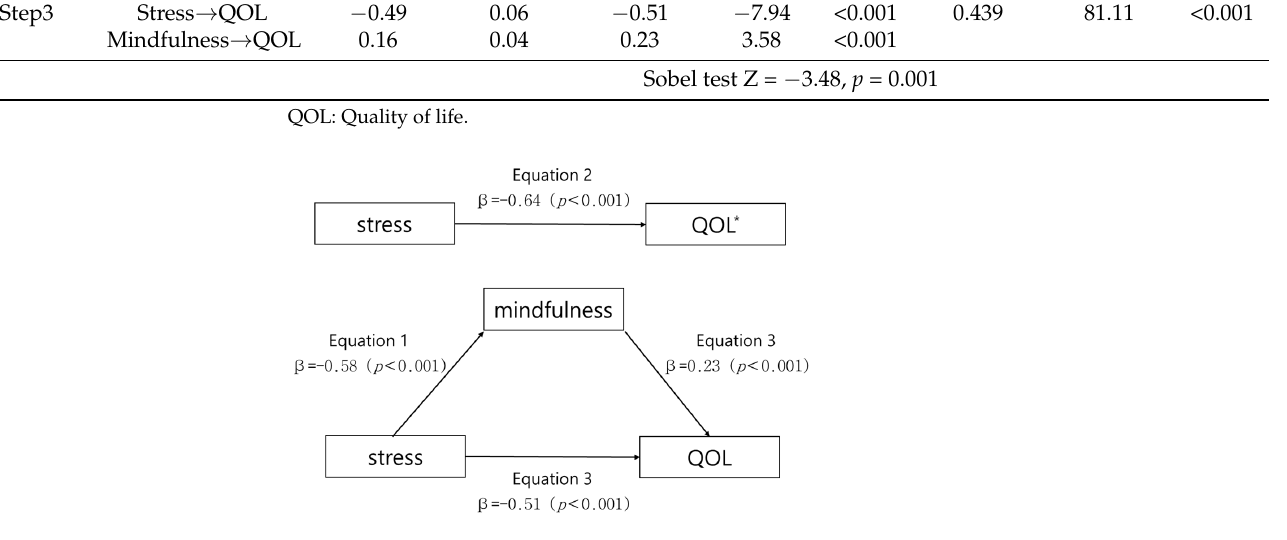
Figure 1. Mediating effect of mindfulness in the relationship between stress and quality of life. * QOL: Quality of life.